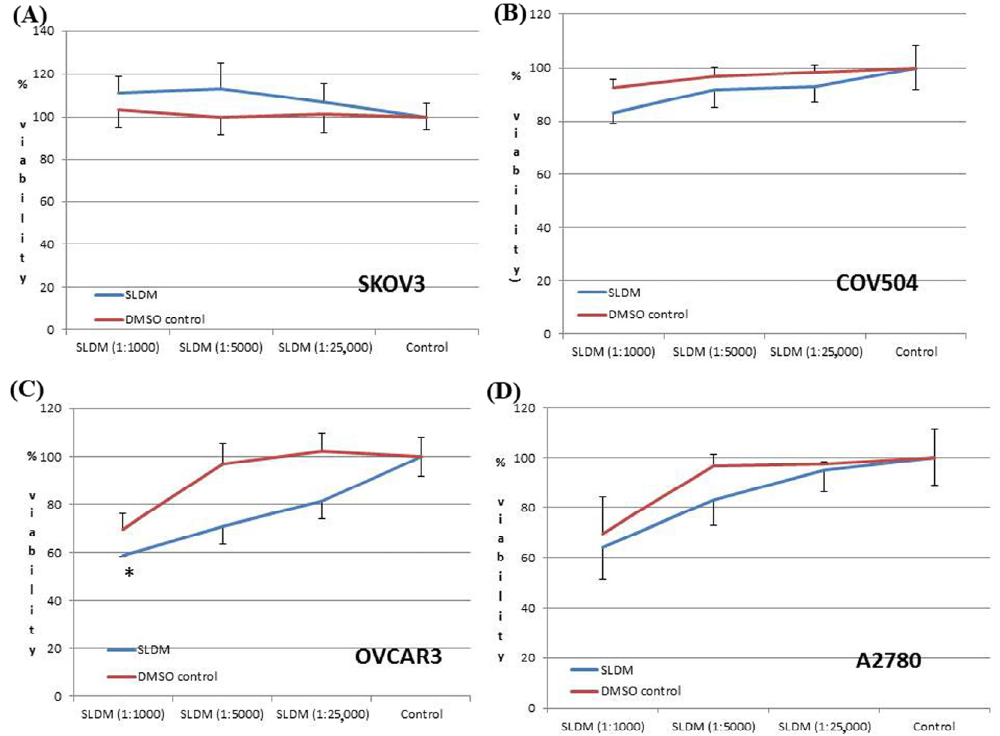
Figure 1. Effects of SLDM treatment on ovarian cancer cell viability. At all the concentrations tested, SLDM treatment had no significant effect on ( A ) SKOV3, ( B ) COV504 and ( D ) A2780 ovarian cell growth. At the highest concentration (1:1000) tested SLDM significantly reduced ( C ) OVCAR-3 cell viability compared to the DMSO control, implying a cytotoxic effect. * p < 0.05 vs. control.